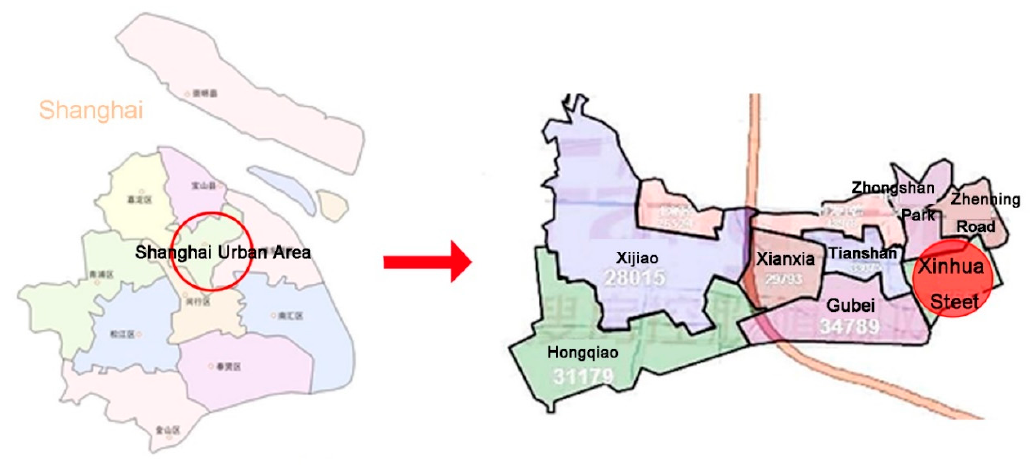
Figure 2. Location of Xinhua Street.